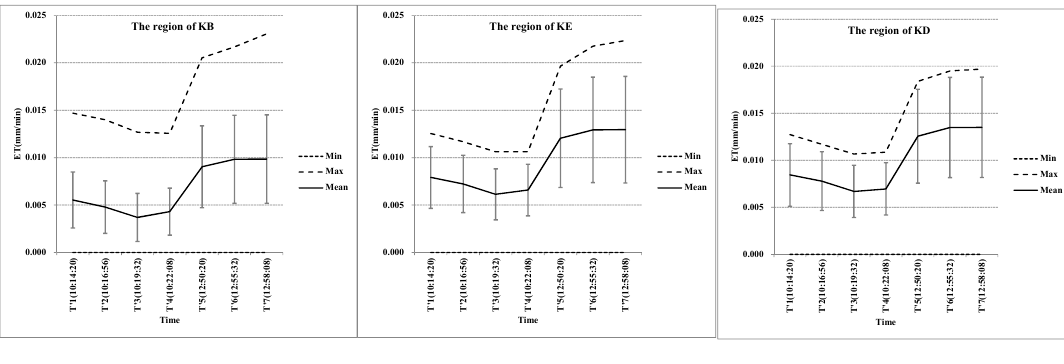
Figure 8. ET of GF-4 at time T (cid:2869)(cid:4593) − T (cid:2875)(cid:4593) in areas KB, KE, and KD (the minimum value, the maximum value, the average value, and the standard error)